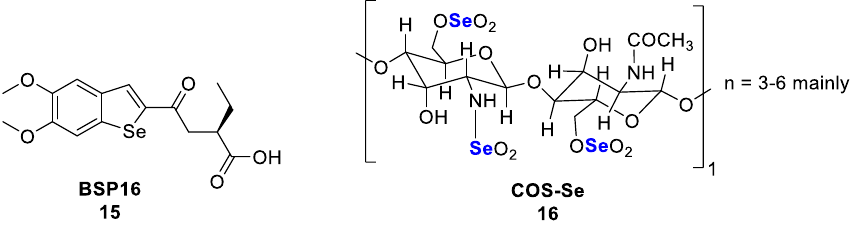
Figure 8. Se-containing compounds 15 and 16 with an immunomodulatory effect in cancer [118,120].